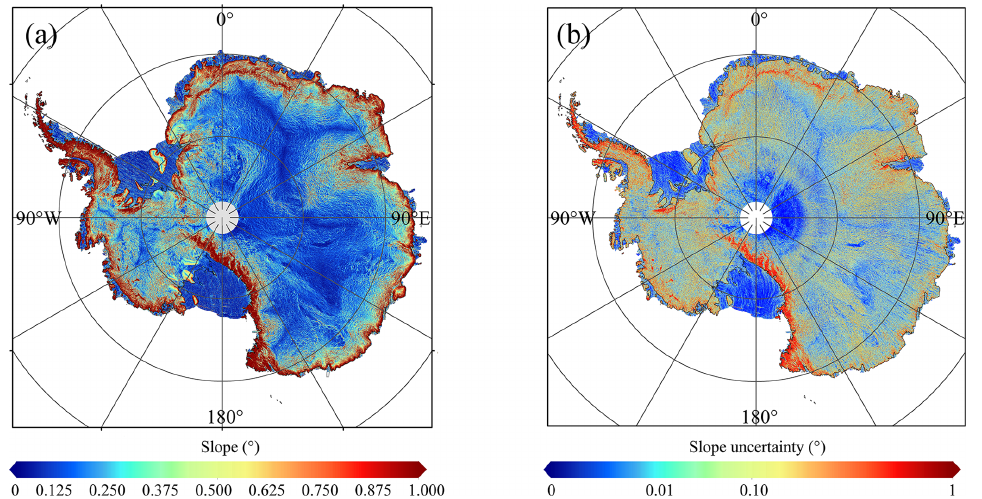
Figure 6. (a) Map of the surface slope of Antarctica derived from the ICESat-2 DEM. (b) Map of the ICESat-2 DEM surface slope uncer- tainty. The uncertainty is estimated based on the propagation of elevation